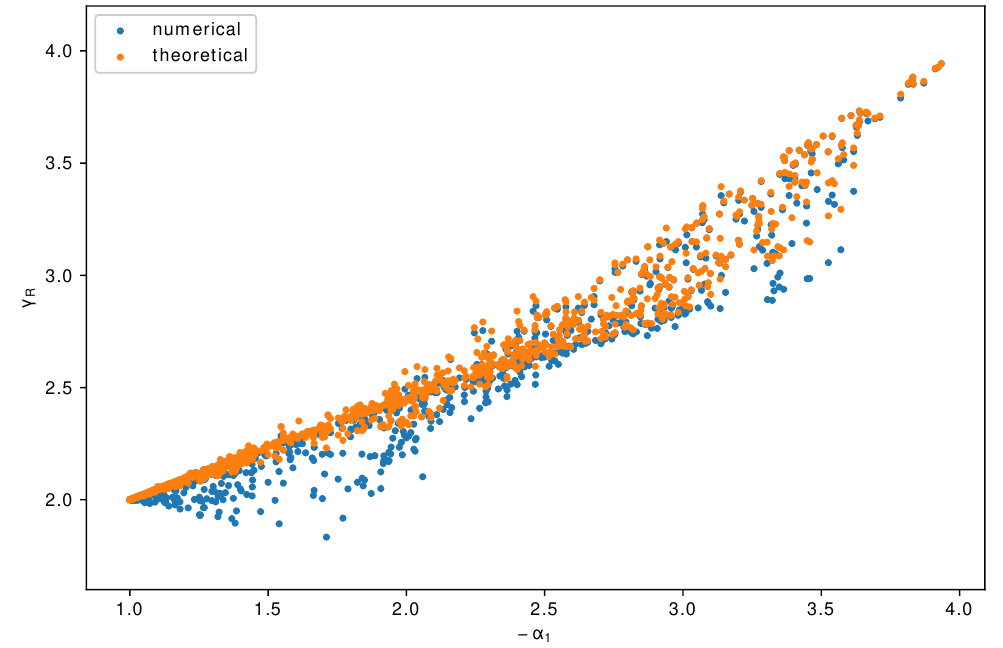
Figure 2 . Theoretical upper bound (orange) and numerical results (blue) versus − α 1 ( x